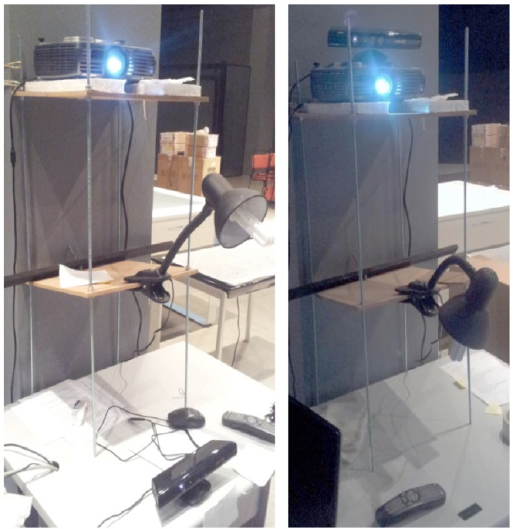
Figure 10 – Different positions used for the Kinect-Projector System.